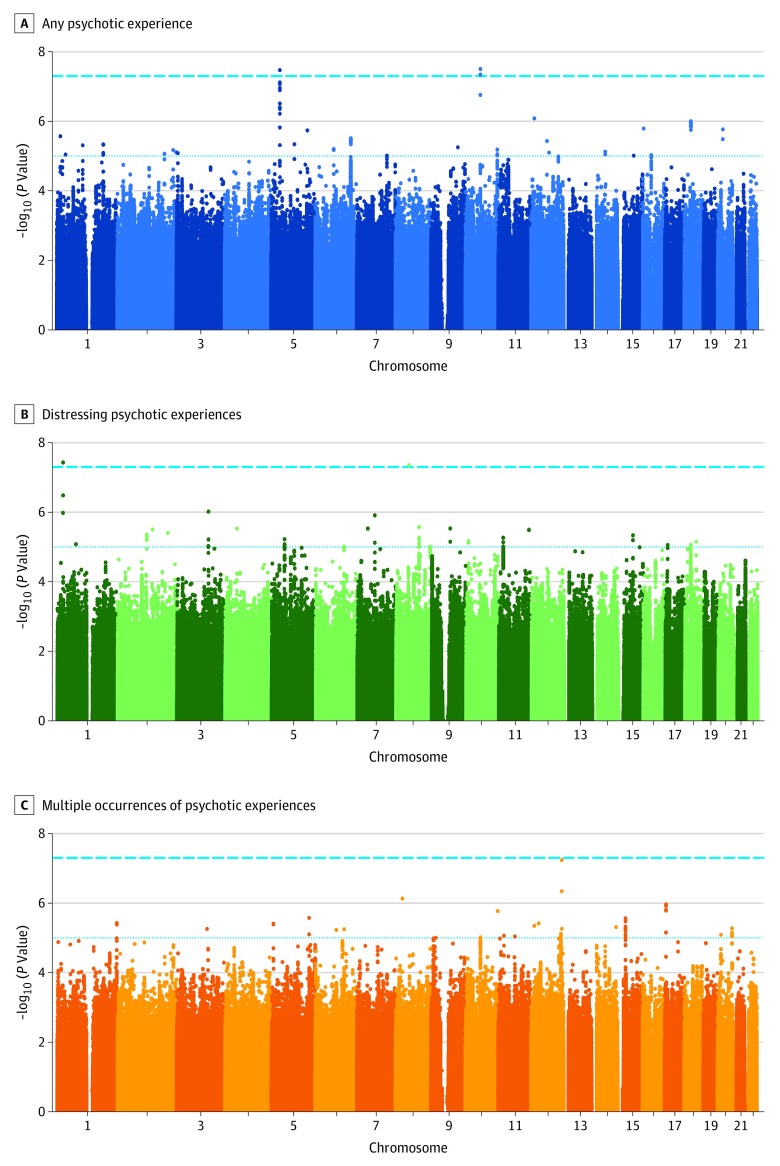
Manhattan Plot for Genome-Wide Association Study Analyses of Any Psychotic Experience, Distressing Psychotic Experiences, and Multiple Occurrences of Psychotic ExperiencesDashed lines represent the genome-wide significance level of P < 5 × 10−8, and dotted lines represent P < 1 × 10−5.